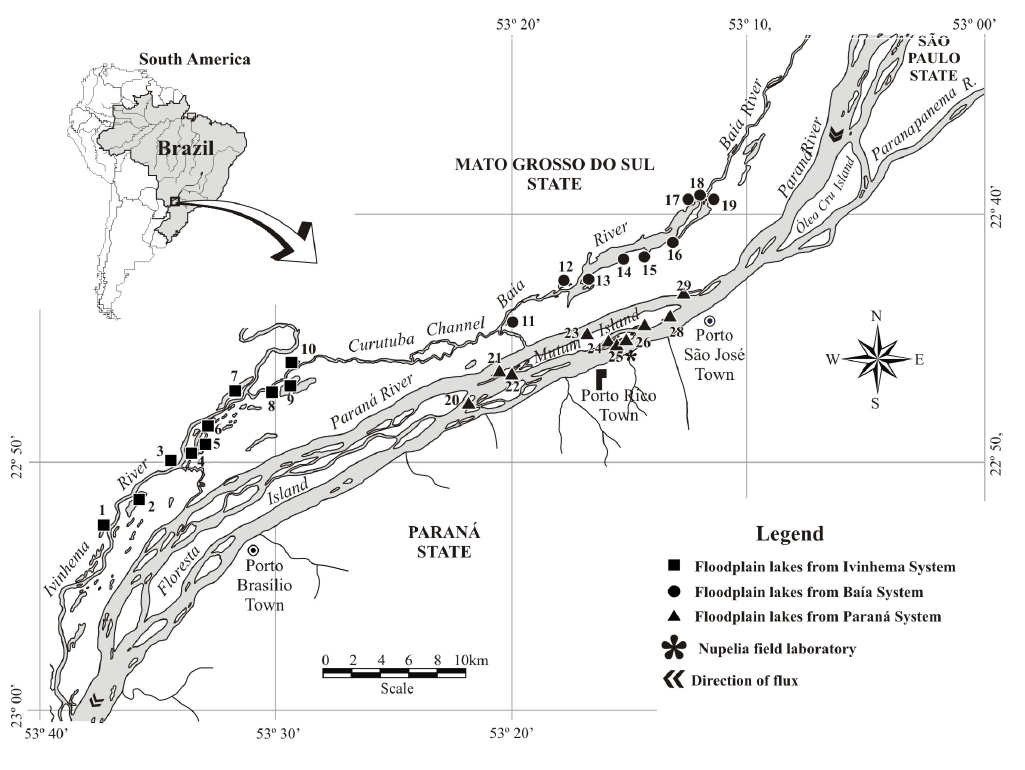
Figure 1. Map of the Upper Paraná River Floodplain with the localization of the sampled lakes. Ivinhema System